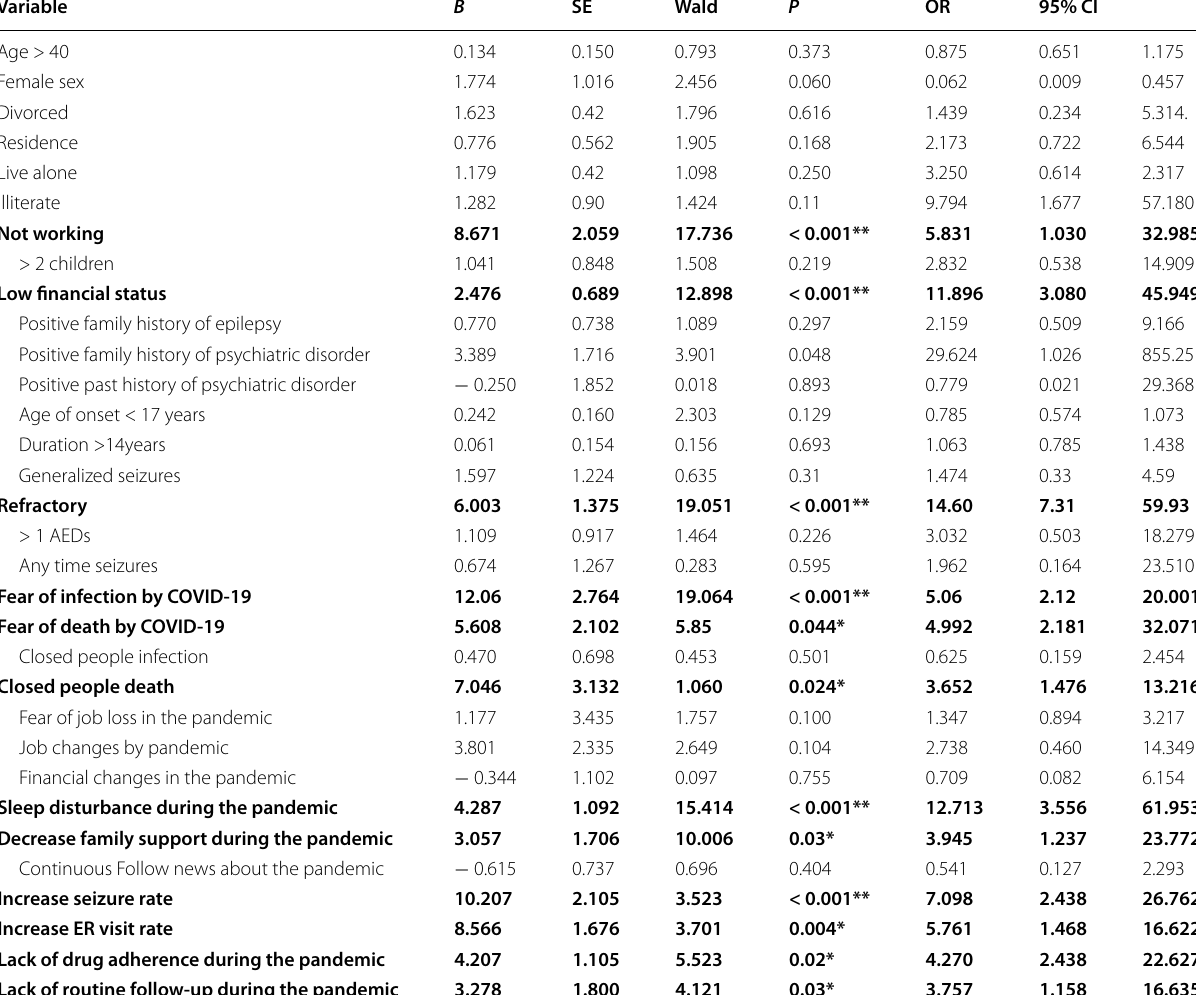
Table 6 Binary logistic regression analysis of the predictors of depression among the studied